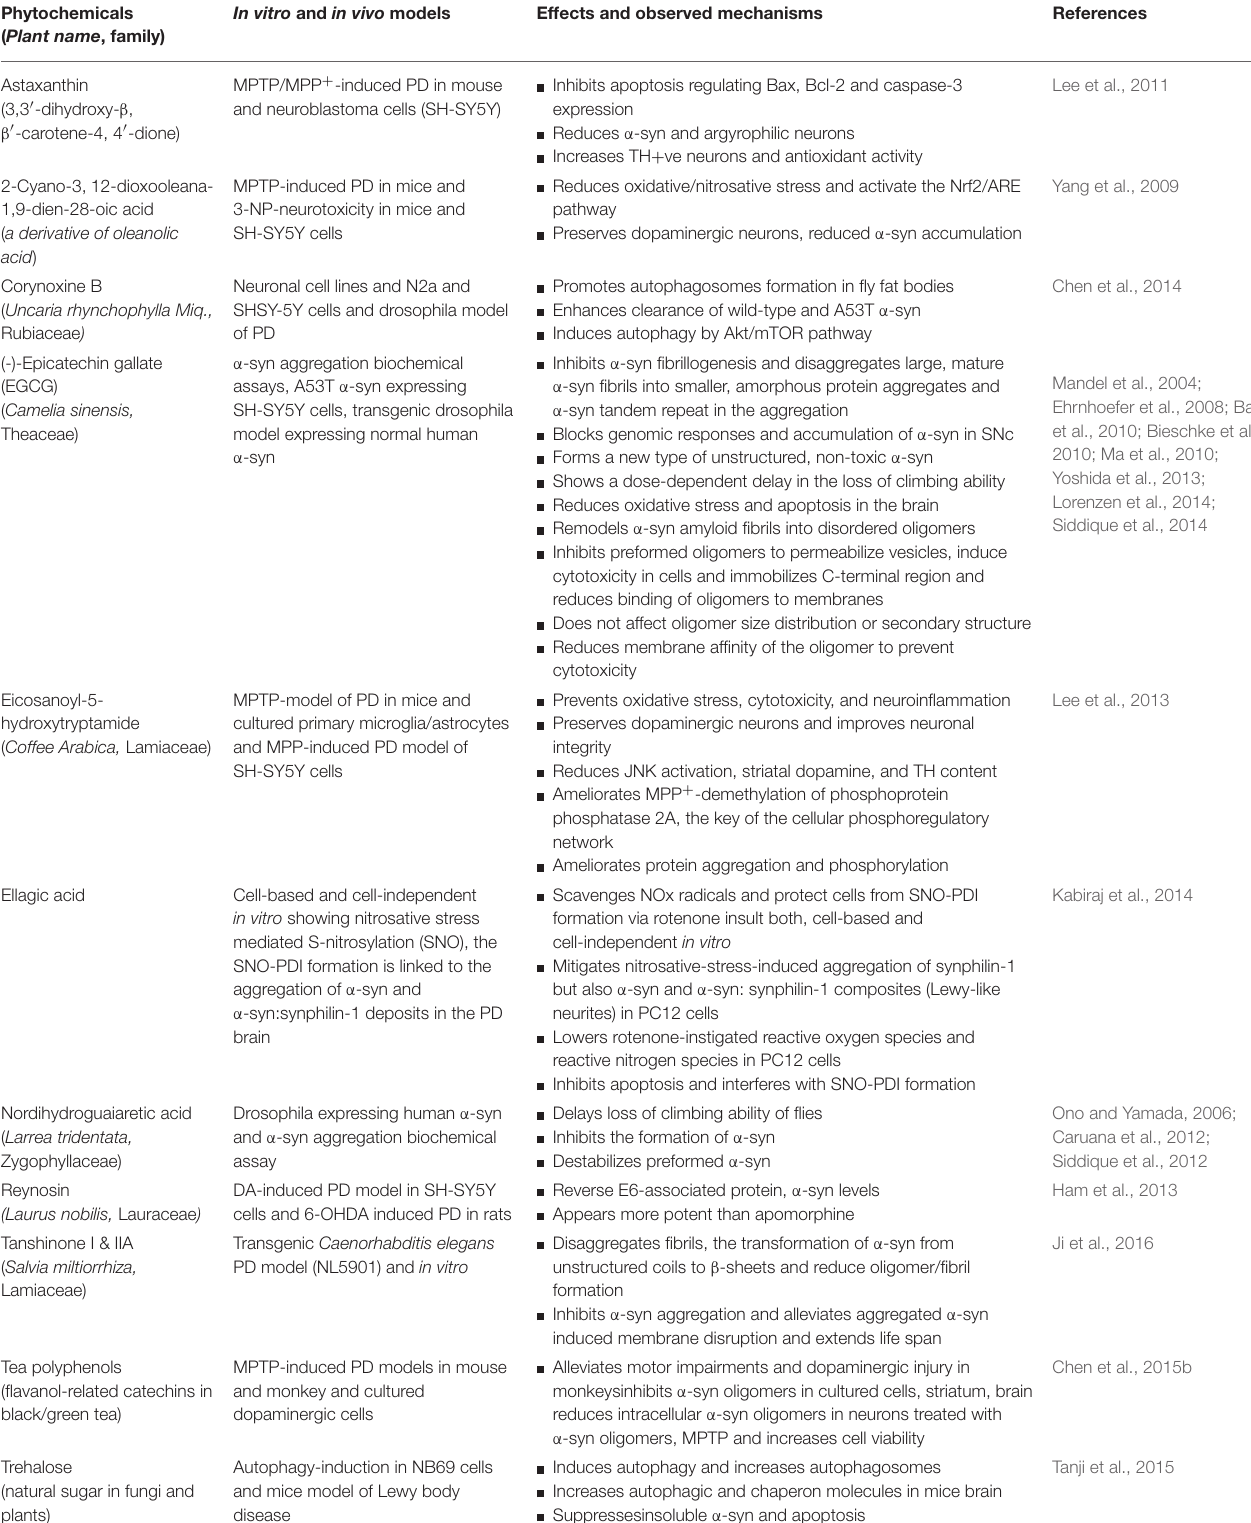
TABLE 4 | The phytochemicals showed neuroprotective effects in both, the in vitro and in vivo models of Parkinson’s disease by targeting α -synuclein. Phytochemicals ( Plant name ,